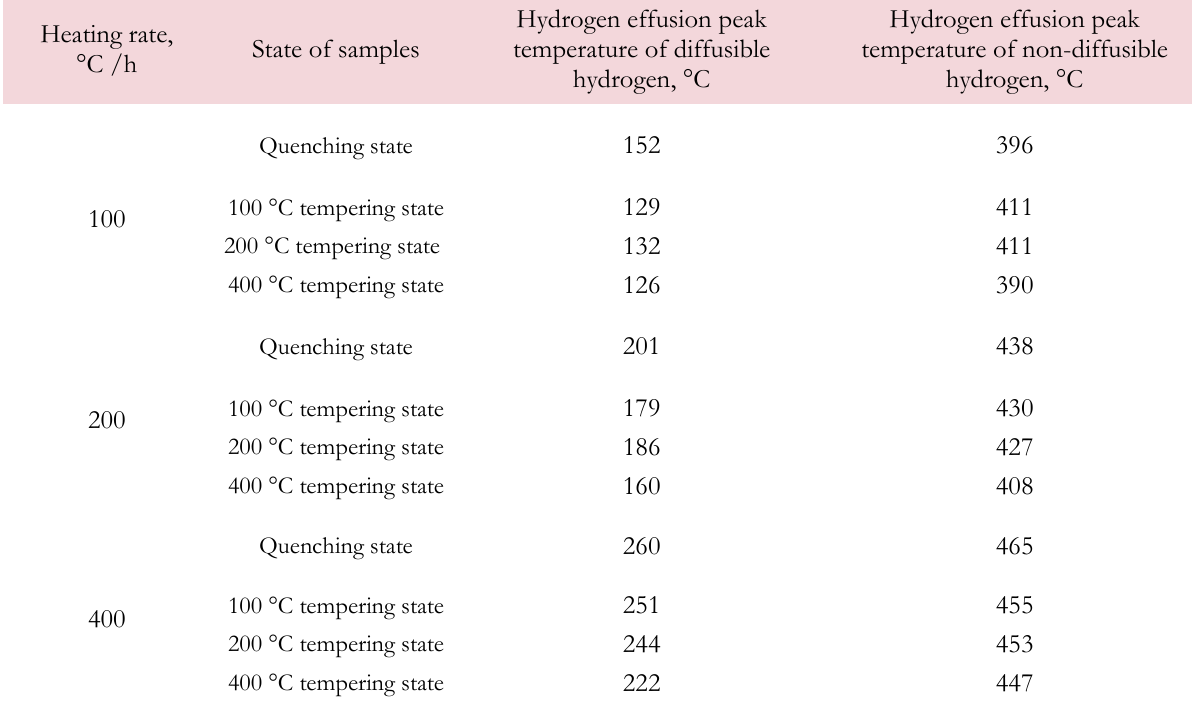
Table 5: Hydrogen effusion peak temperature of hydrogen effusion curves of experimental materials processed by different heating